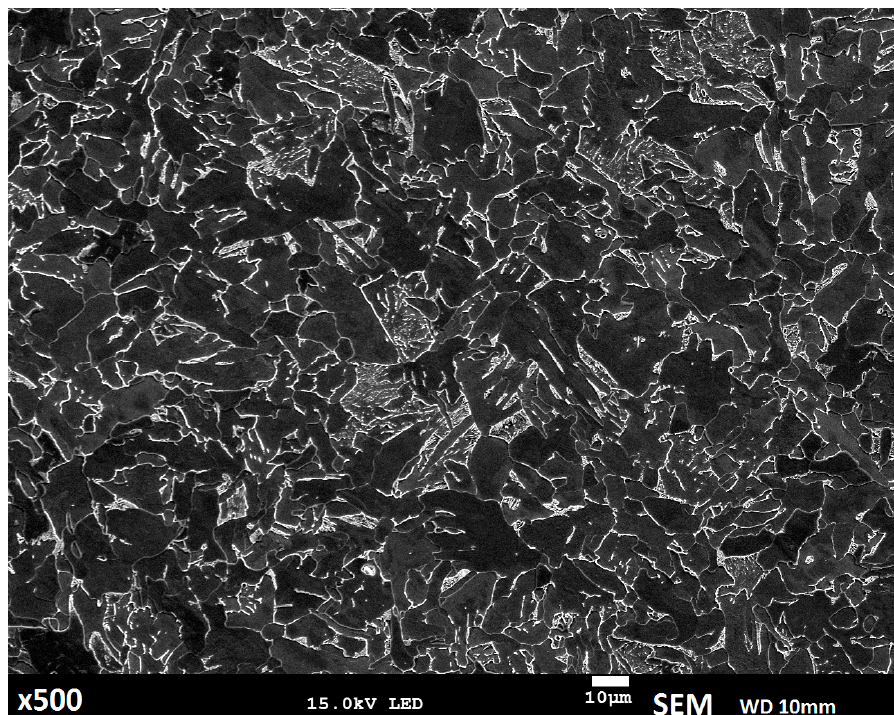
Figure 3. Microstructure of the substrate material.